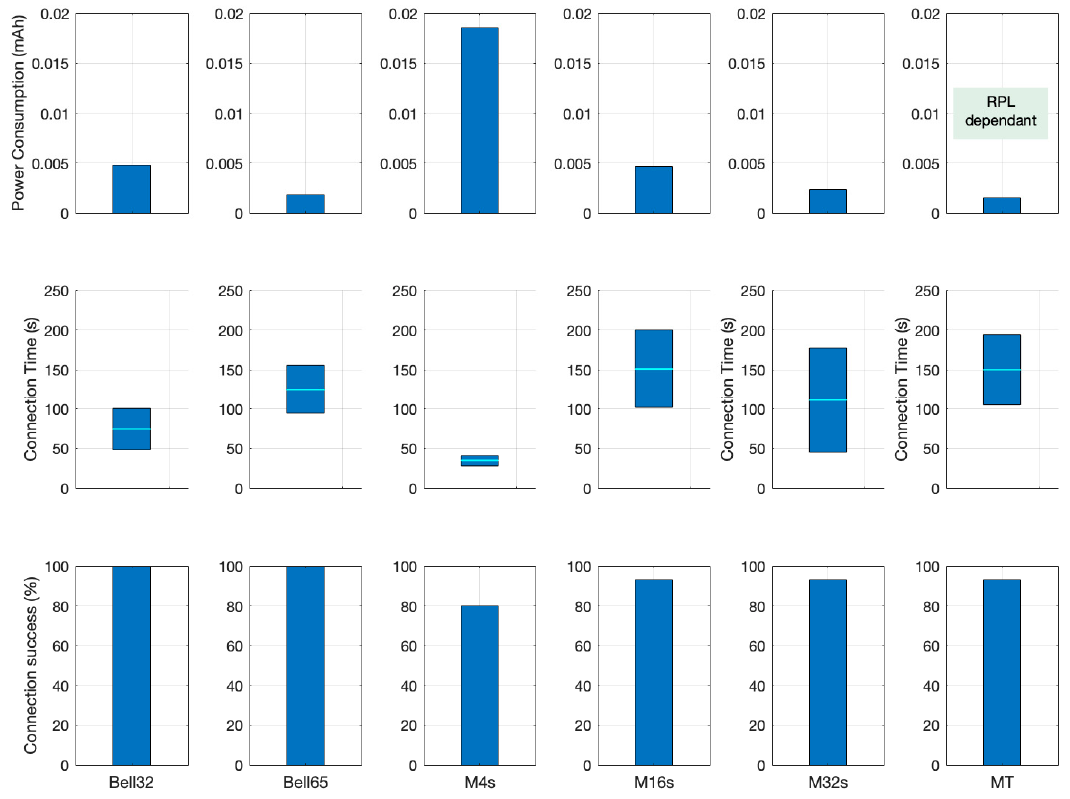
Figure 19. Key Performance Index (KPI) Comparison for tested configurations.